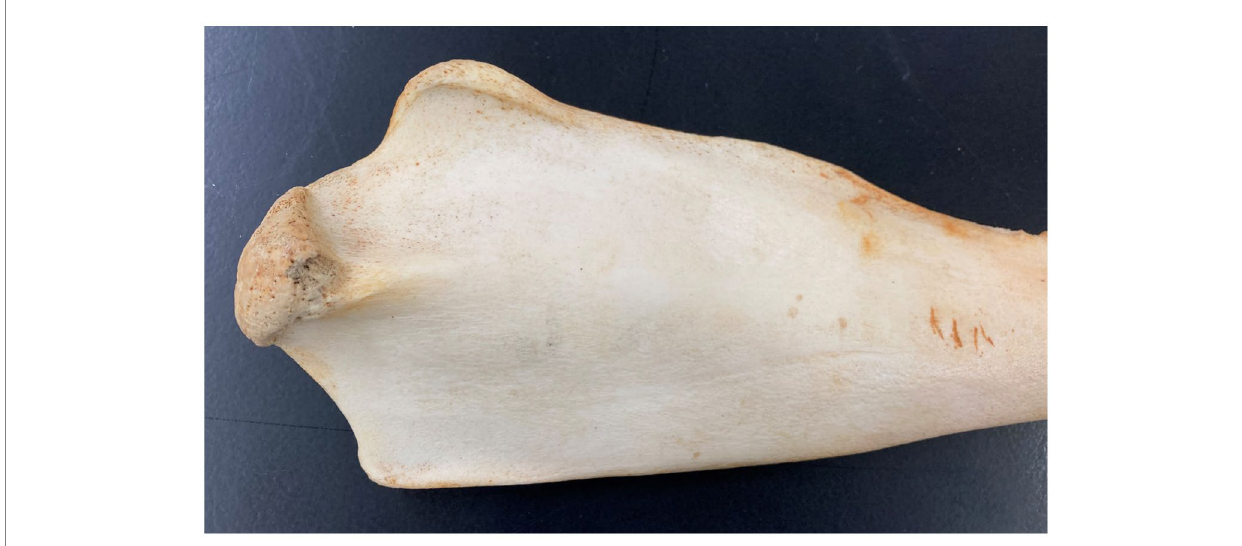
FIGURE 3 Mandibular condyle and coronoid in bottlenose dolphin, Tursiops